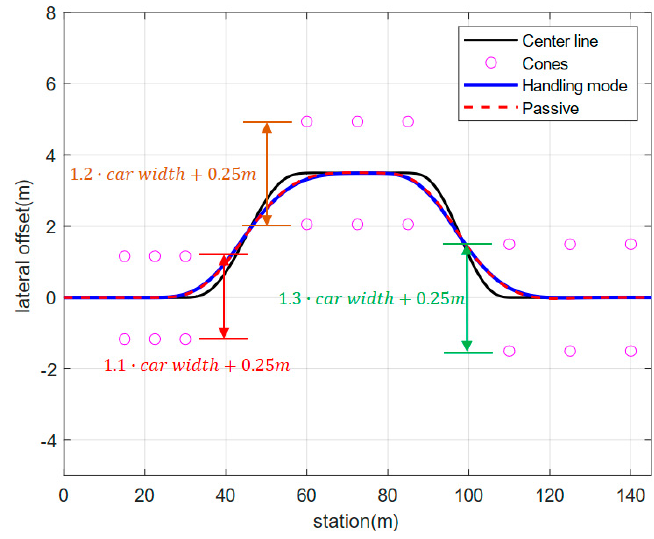
Figure 14. Track layout and trajectories for ISO 3888-1.